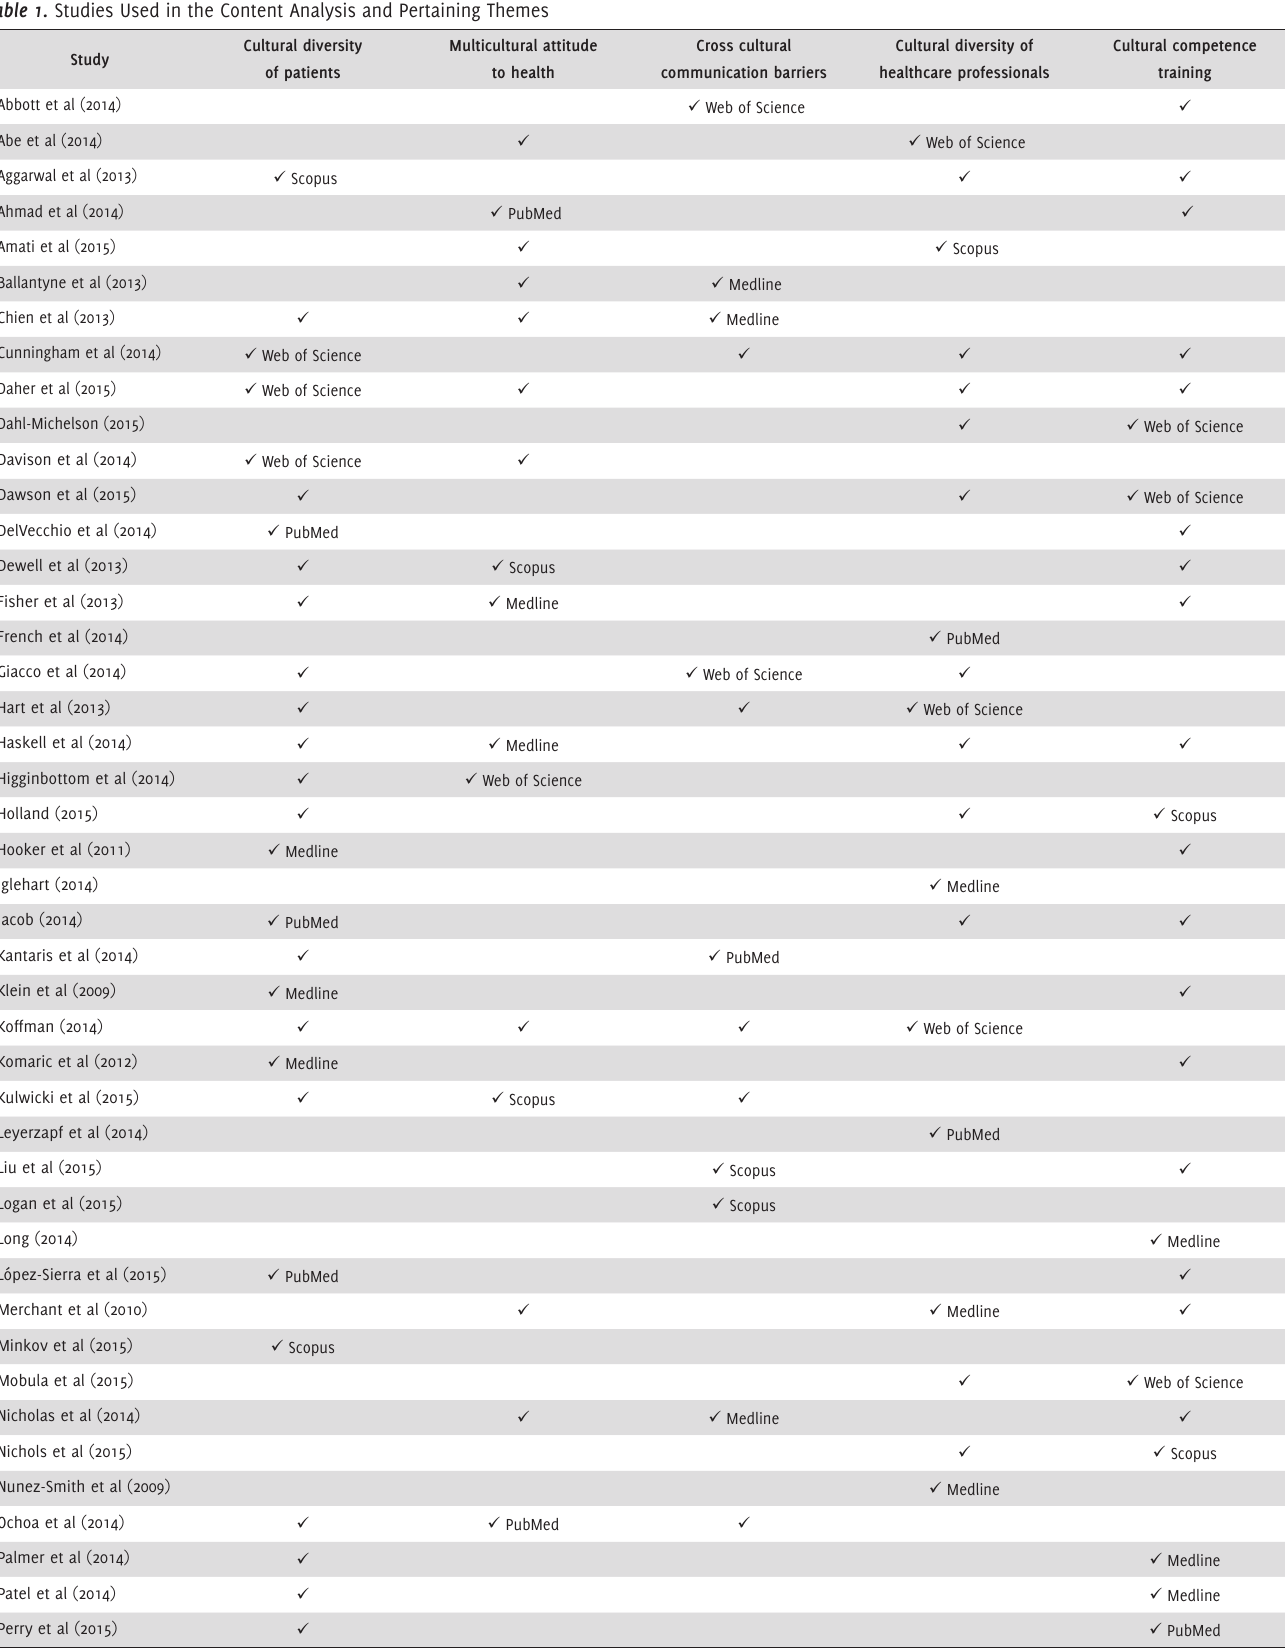
Table 1. Studies Used in the Content Analysis and Pertaining